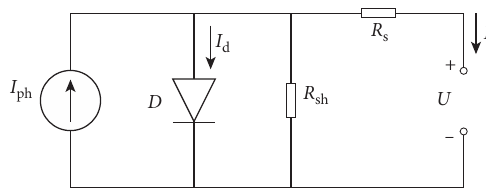
Figure 1: The equivalent circuit of a single PIN